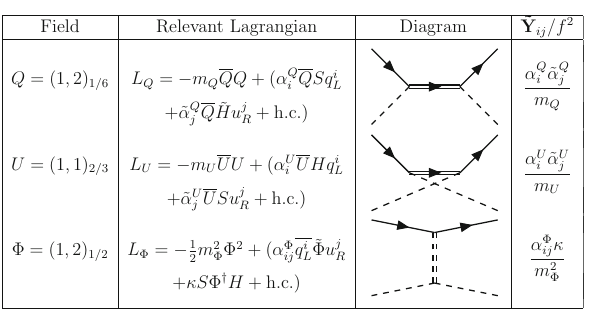
Table 1 Single field extensions of the SM supplemented with S that induce the FCNC of interest at low energy at tree level. The numbers in parenthesis and the subscript denote the SU ( 3 ) c and SU ( 2 ) L represen- tations and the hypercharge, respectively. From the top left and clock- wise, the different diagram legs represent q i , t j , H and S , respectively R L Field Relevant Lagrangian